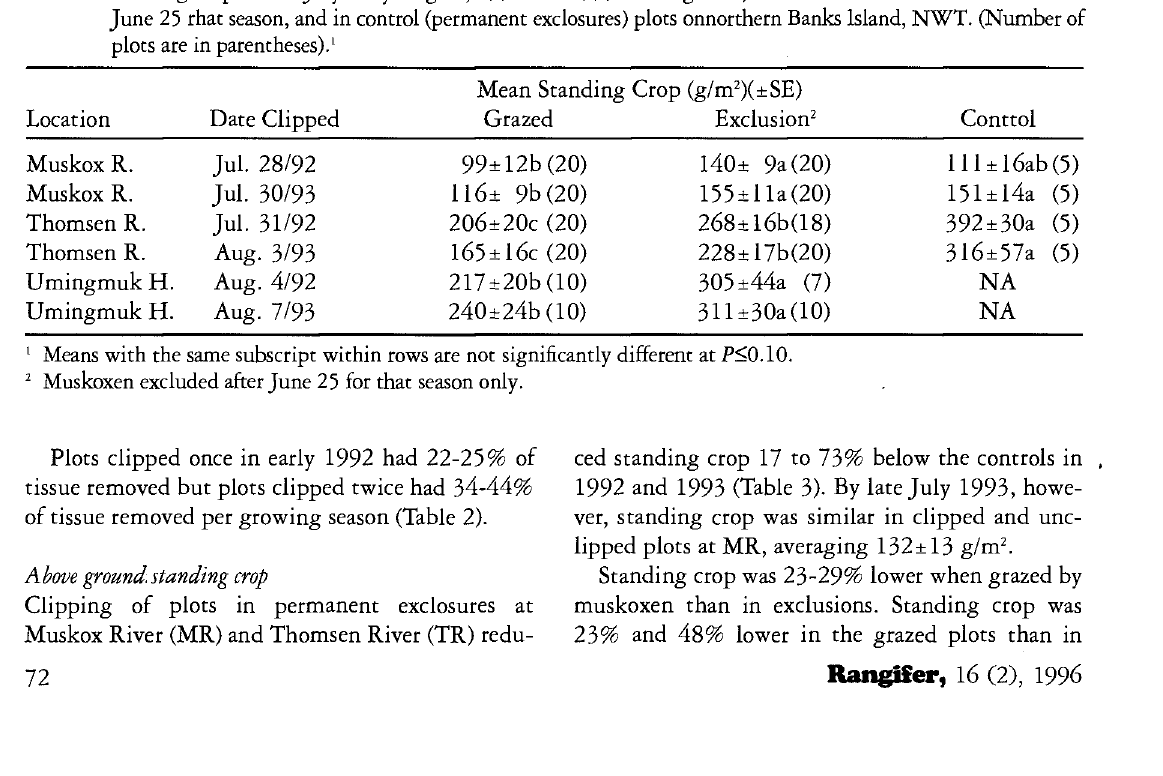
Table 4. Standing crop in late July-early August, 1992 and 1993 where grazed, where muskoxen were excluded June 25 rhat season, and in control (permanent exclosures) plots onnorthern Banks Island, N W T. (Number of plots are in parentheses).